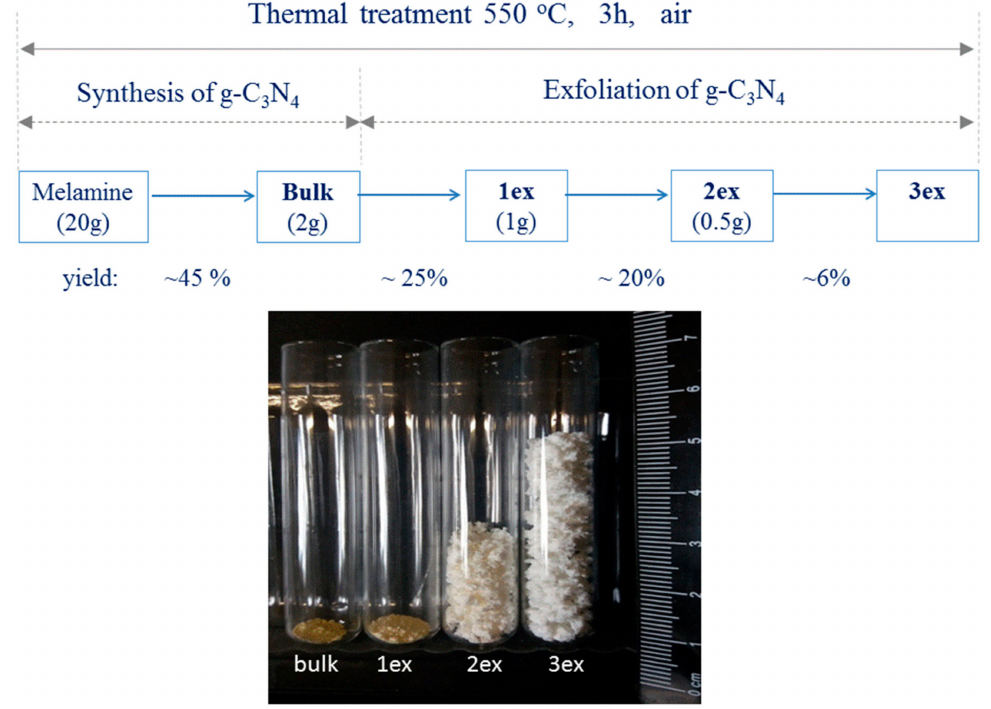
Figure 15. Schematic presentation of samples’ preparation where the precursor mass in gram and the yield of each treatment in percent are given; photograph of equal quantity 0.030 g of the bulk and exfoliated (1ex, 2ex and 3ex) g-C 3 N 4